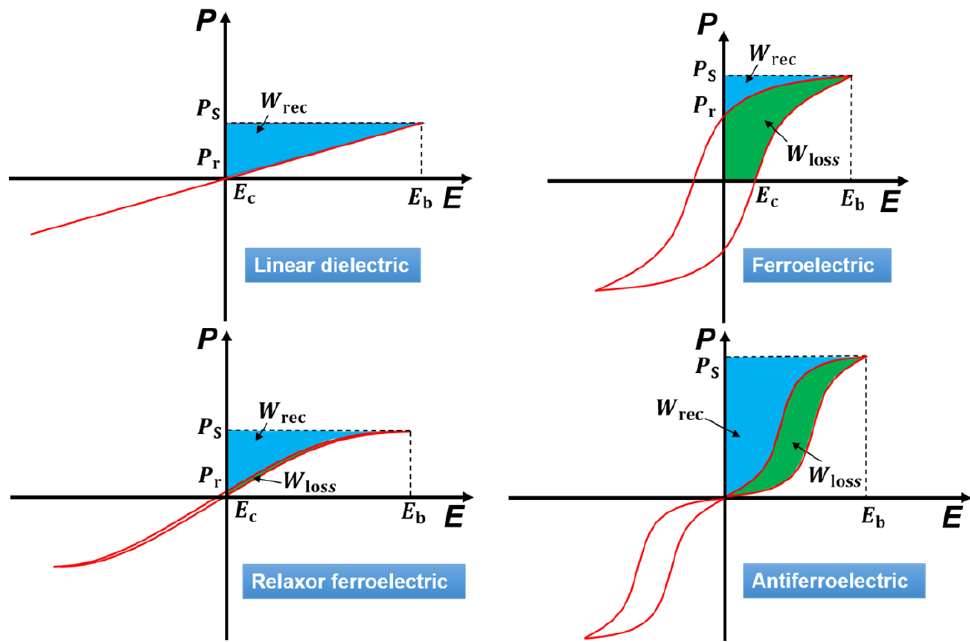
Fig. 4 Schematic diagram of the hysteresis loops (polarization as a function of electric field) for: (a) linear dielectrics, (b) ferroelectrics, (c) relaxor ferroelectrics, and (d)